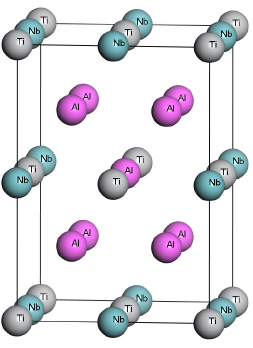
Figure 1. The unit cell of γ 1 -Ti 4 Nb 3 Al 9